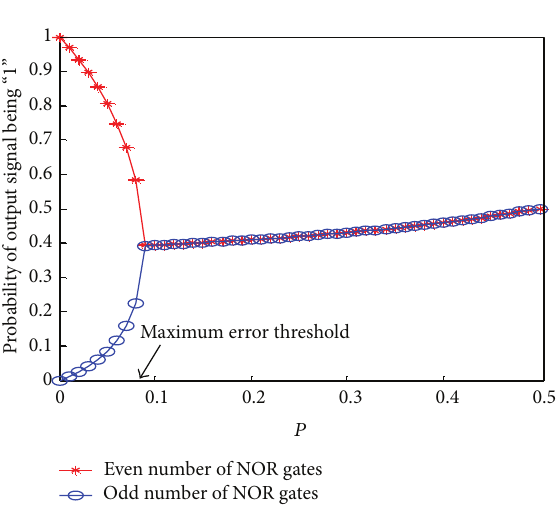
Figure 10: Graph plot for NOR